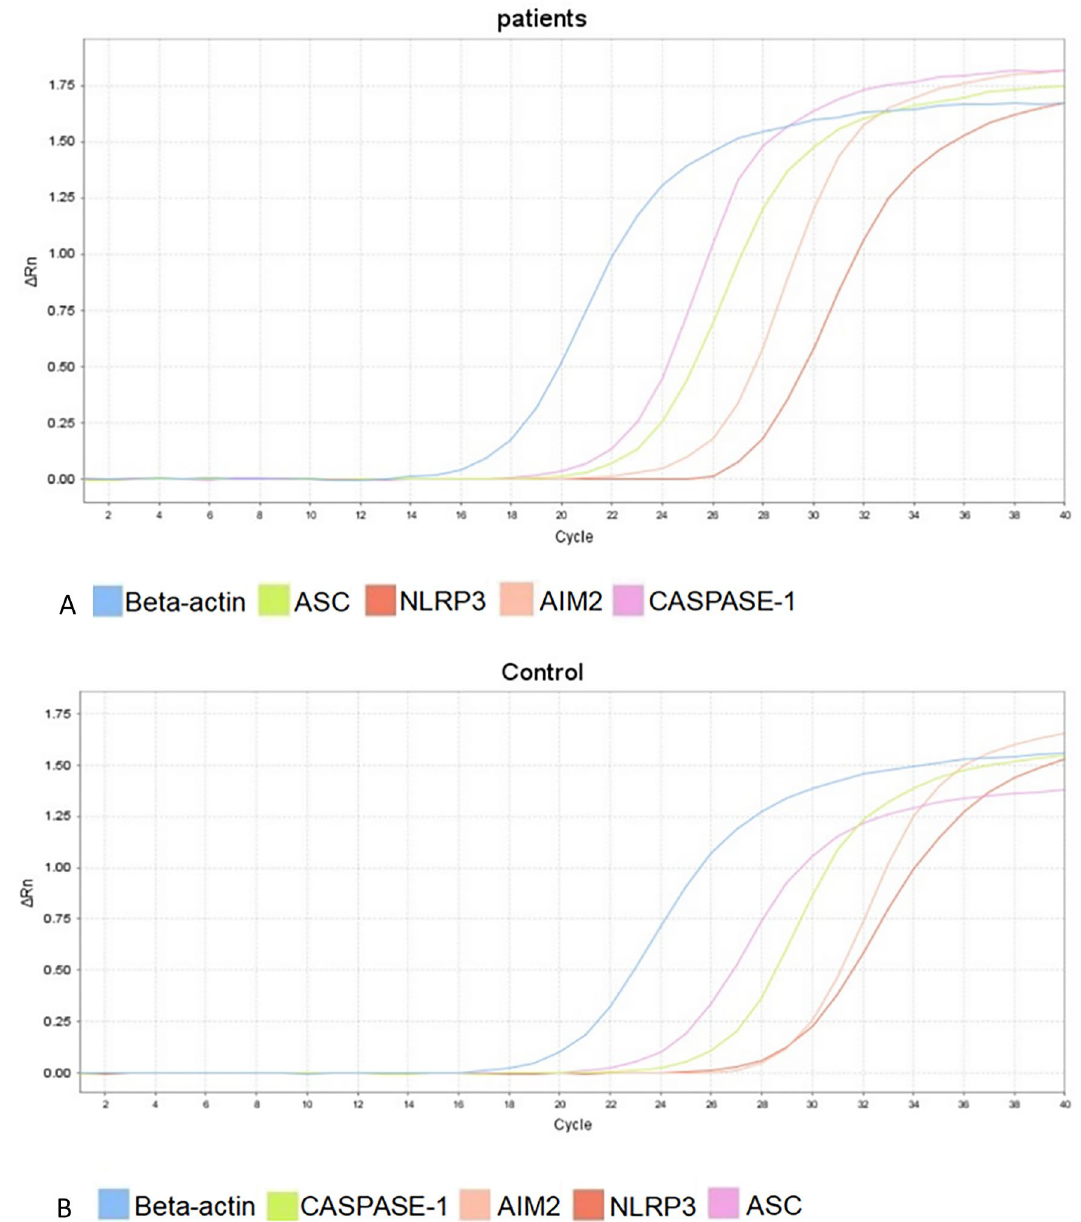
Figure 1. Representative amplification curves ( A ) Representative amplification curves of cDNA from patient groups for each gene. ( B ) Representative amplification curves of cDNA from control groups for each gene. Total RNA samples were extracted from peripheral blood. 1 μg of RNA was used for reverse transcription synthesis of cDNA. RT-PCR was subsequently performed with